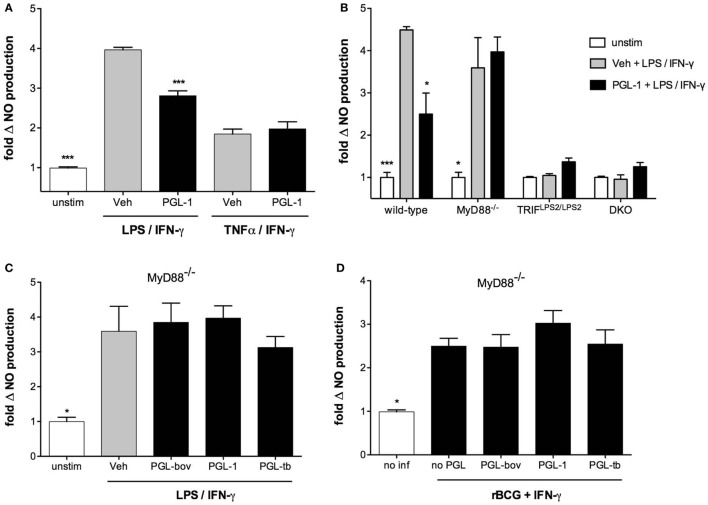
Phenolic glycolipids (PGLs) impair TLR4-mediated downstream signaling pathways. (A) Differential production of NO by bone marrow-derived macrophages (BMDMs) pretreated with 25 µM PGL-1 or vehicle (Veh) for 24 h prior to a 24 h stimulation with 1 µg/ml LPS + 100 U/ml IFN-γ, or 10 ng/ml TNF-α + 100 U/ml IFN-γ. ***P < 0.001, Mann–Whitney test, comparing PGL-1-treated to vehicle controls in each condition of cell stimulation. (B) Differential production of NO by wild-type, MyD88−/−, TRIFLps2/Lps2, or DKO BMDMs treated with 25 µM PGL-1 or vehicle (Veh) for 24 h prior to a 24 h stimulation with 1 µg/ml LPS + 100 U/ml IFN-γ. Controls include non-treated, non-stimulated cells (unstim). (C) Differential production of NO by MyD88−/− BMDMs treated with 25 µM PGL-bov, 25 µM PGL-1, 25 µM PGL-tb, or vehicle (Veh) for 24 h prior to a 24 h stimulation with LPS/IFN-γ. (D) Differential production of NO by MyD88−/− BMDMs infected with rBCG:no PGL, rBCG:PGL-bov, rBCG:PGL-tb, or rBCG:PGL-1 at a MOI of 5:1, or non-infected (no inf). In (B–D), data are mean NO levels ± SEM (n ≥ 3), expressed as fold changes relative to non-stimulated (unstim) or non-infected (no inf) controls. Data shown are from one experiment repeated twice with similar results. *P < 0.05, **P < 0.01, ***P < 0.001, repeated measures ANOVA with Tukey post hoc test, relative to vehicle or no PGL controls.